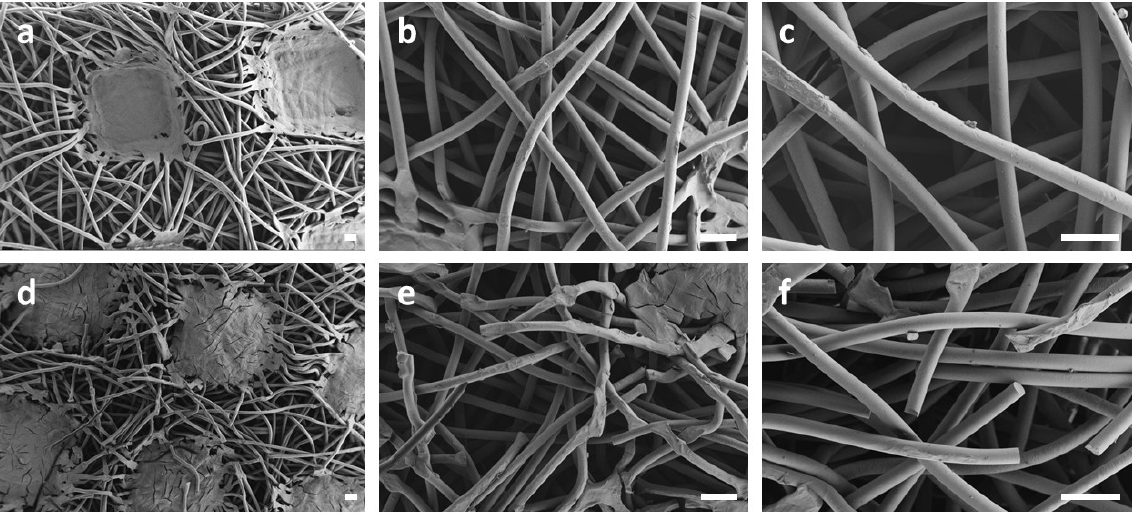
Figure 1. Weight changes of the layers exposed to isothermal aging at 110 °C as a function of treat- ment time.